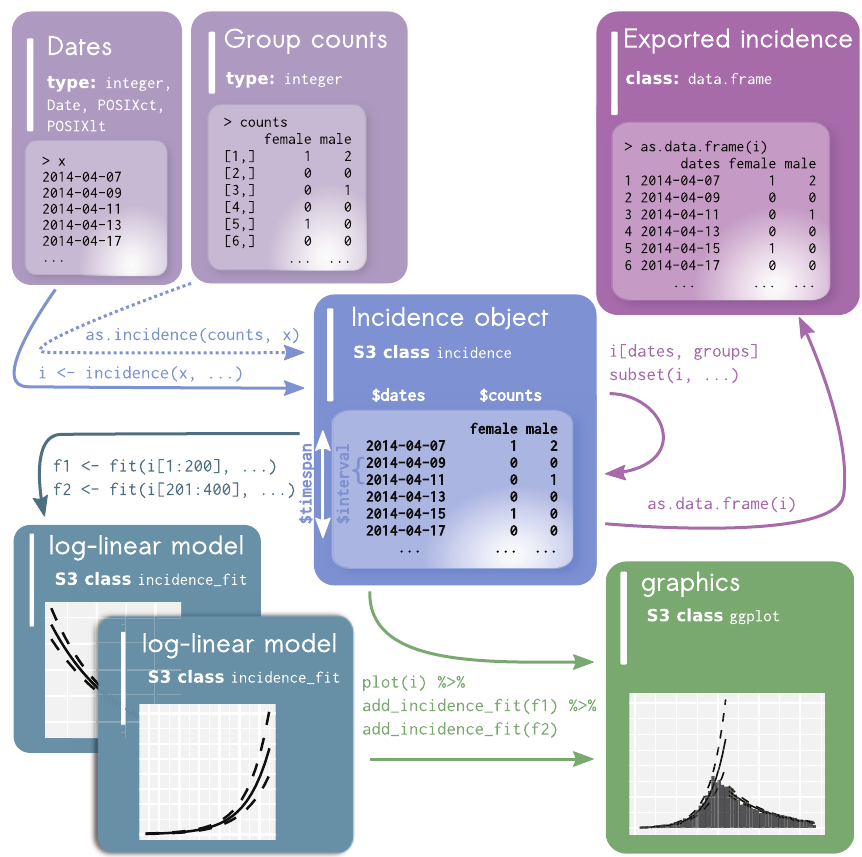
Figure 1. Generalized workflow from incidence object construction to modeling and visualization. The raw data is depicted in the top left as either a vector of dates for each individual case (typical usage) or a combination of both dates and a matrix of group counts. The incidence object is created from these where it checks and validates the timespan and interval between dates. Data subsetting and export is depicted in the upper right. Data visualization is depicted in the lower right. Addition of log-linear models is depicted in the lower